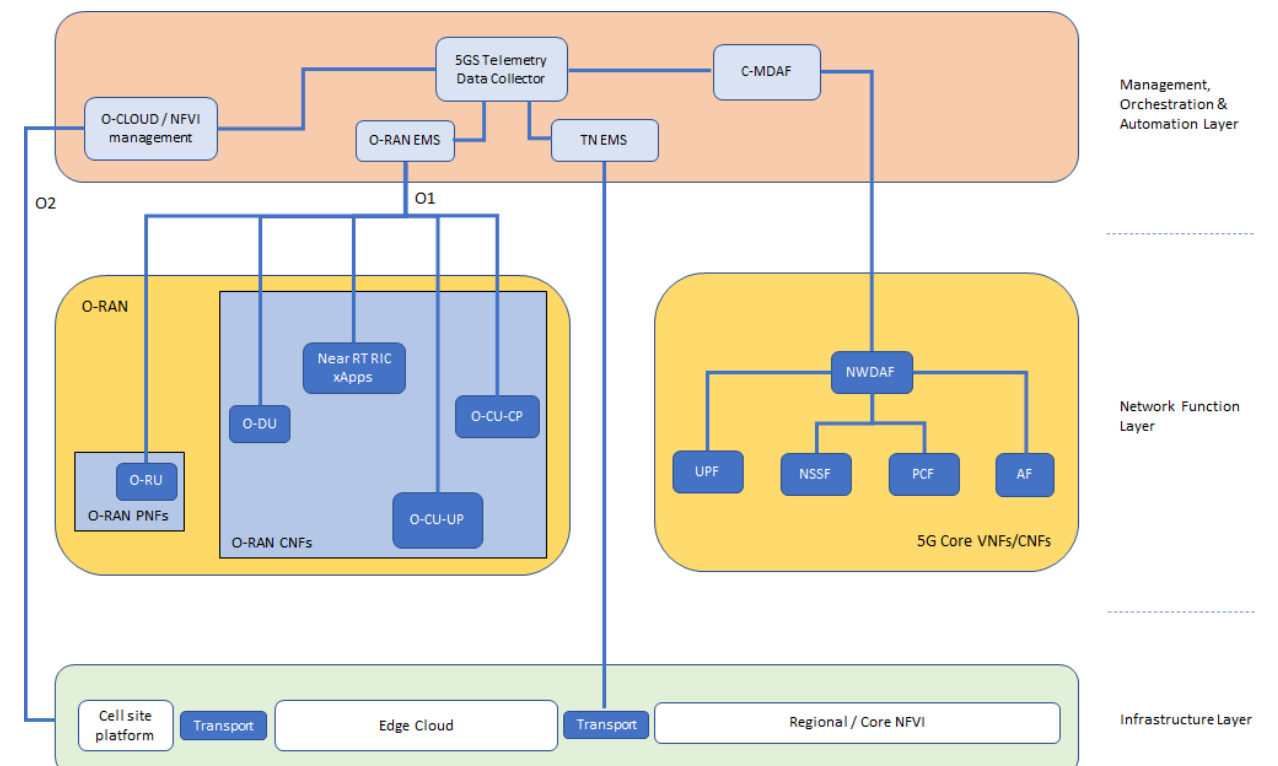
Figure 5. Proposed architecture for NT functionalities.